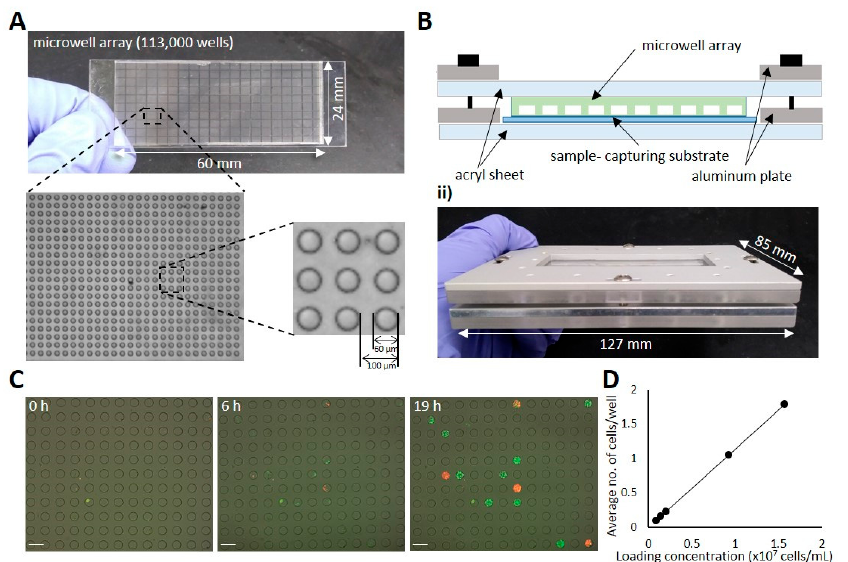
Figure 2. Microwell array chip. ( A ) Photograph of a microwell array with 113,000 microwells. ( B ) Microwell array chip fixed by a chip holder. ( C ) Microscopy images of microwells loaded with a mixture of red fluorescent protein (RFP)-expressing cells or green fluorescent protein (GFP)-expressing cells. Brightfield and fluorescence images were acquired after 0, 6, and 19 h of incubation and merged for visualization. All scale bars are 200 µ m. ( D ) The relationship between cell loading concentration and the average number of cells trapped in